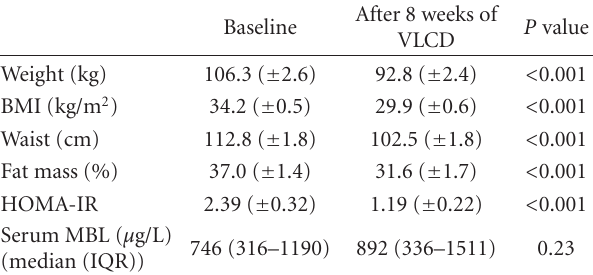
Table 1: Clinical characteristics of